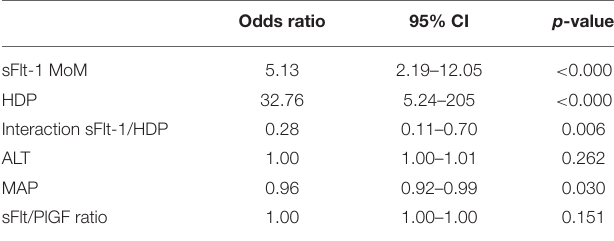
TABLE 3 | Multivariate factorial model for adverse maternal